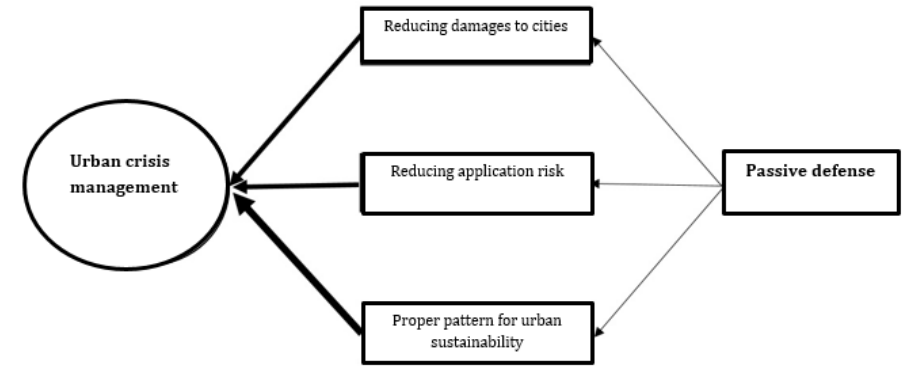
Table 1: Analysis of demographic characteristics of the respondents Fig. 1: Conceptual model of the research